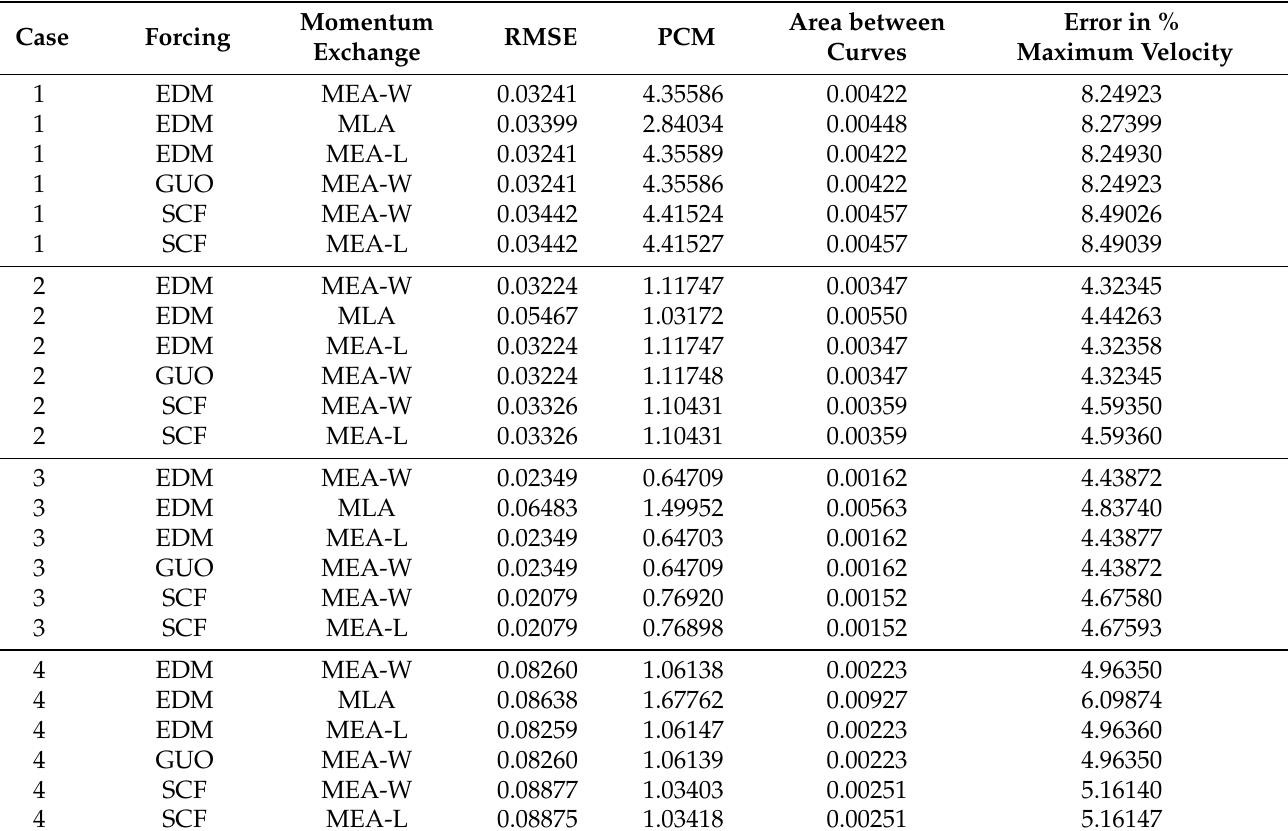
Table 3. Different error measures [80] for the four cases described by ten Cate et al. [45] for various combinations of momentum exchange and forcing schemes. The error in terminal velocity is given relative to the analytical values according to Abraham [60]. The results in the table refer to N = 8.